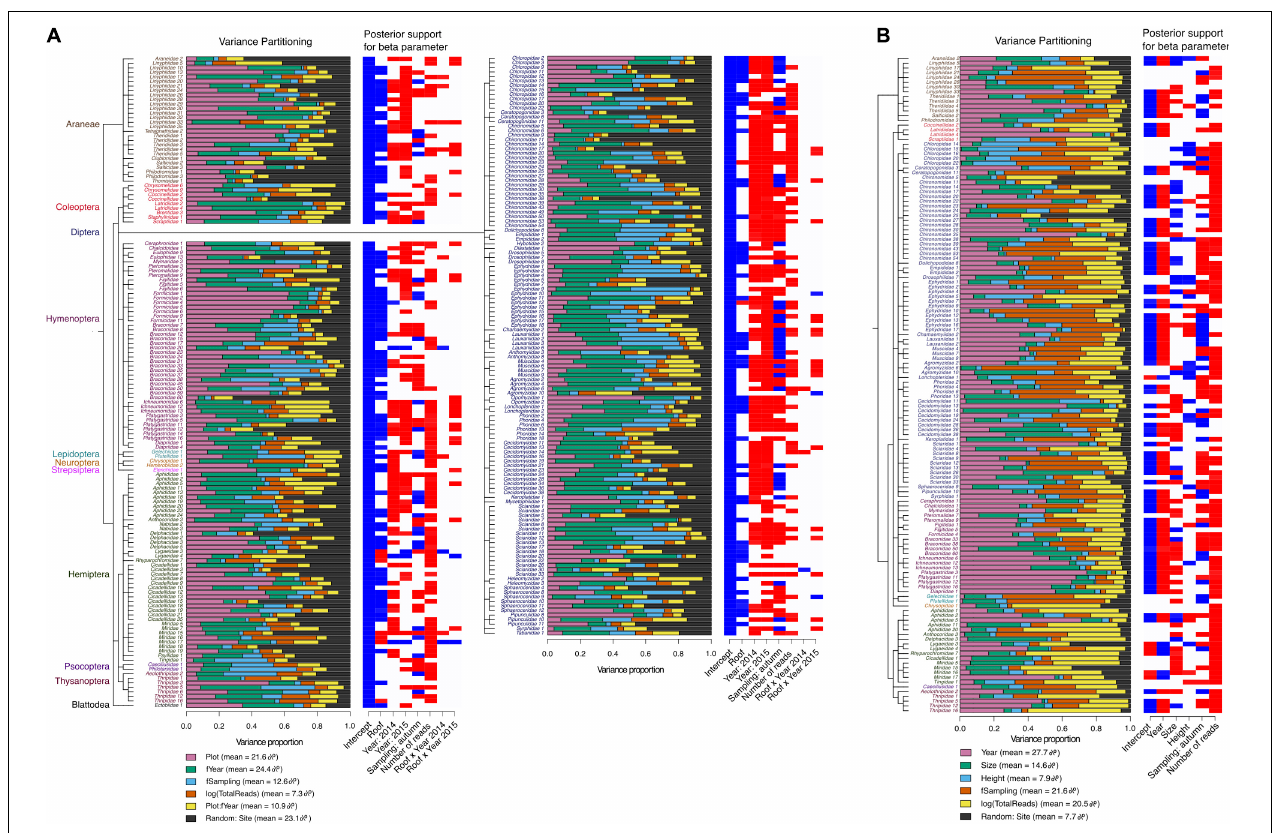
FIGURE 3 | Proportion of variance explained by fixed and random effects (Variance partitioning, panels on the left) and posterior regression parameter values (Posterior support for beta parameter, panels on the right) showing species responses to model covariates. Model covariates are plotted in columns and species in rows. Fixed effects in the roof vs. ground model (A) include plot (roof or ground level), year as a three-level factor (2013, 2014, or 2015), sampling as a two-level factor (early or late summer), logarithm of the total number of reads (i.e., sequencing depth) and the plot x year interaction. Fixed effects of the roof model (B) include year as continuous variable, roof size, height, sampling and logarithm of read count. Random variation is at site level in both models. In the posterior regression parameter values, blue indicates negative responses and red positive with ≥ 0.95 posterior probability. Species order in A and B follows their phylogenetic relationships and IDs for species belonging to the same order have matching font colors. Diptera species are shown separately from other taxa for the roof vs. ground model (A) . The roof vs. ground model data included 268 species (at least 10 occurrences in the whole data) and roof model data had 138 species (those with at least five occurrences in the roof